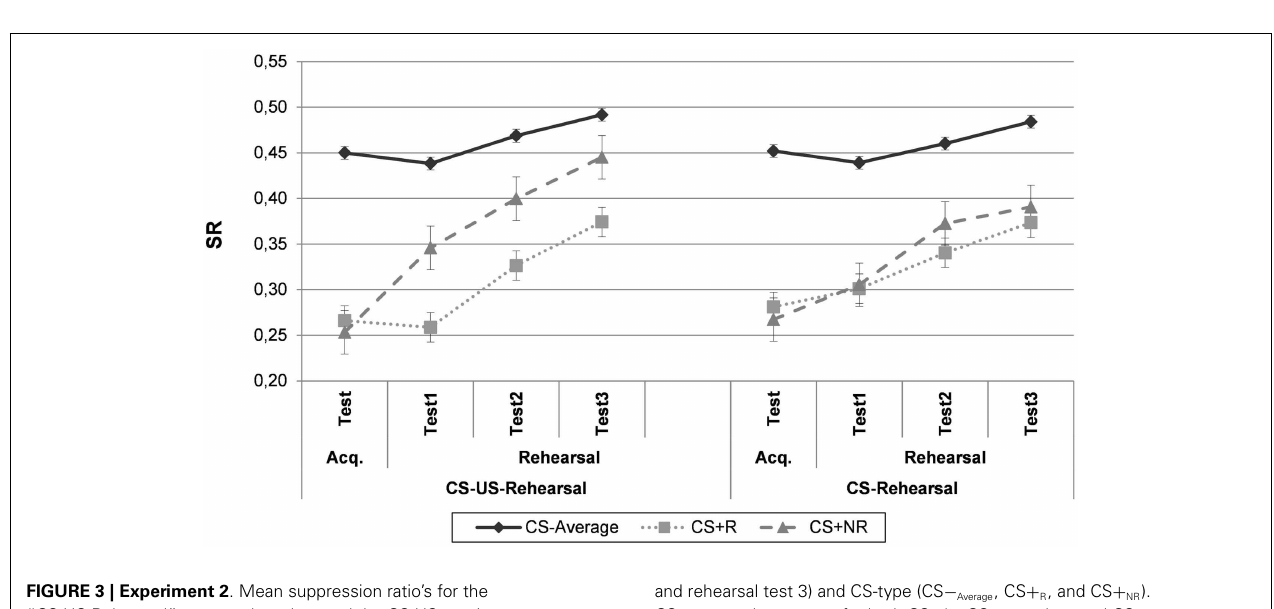
FIGURE 3 | Experiment 2 . Mean suppression ratio’s for the “CS-US-Rehearsal”-group, who rehearsed the CS-US-contingency, and the “CS-Rehearsal”-group, who rehearsed only the CS, as a function of phase (acquisition test, rehearsal test 1, rehearsal test 2,